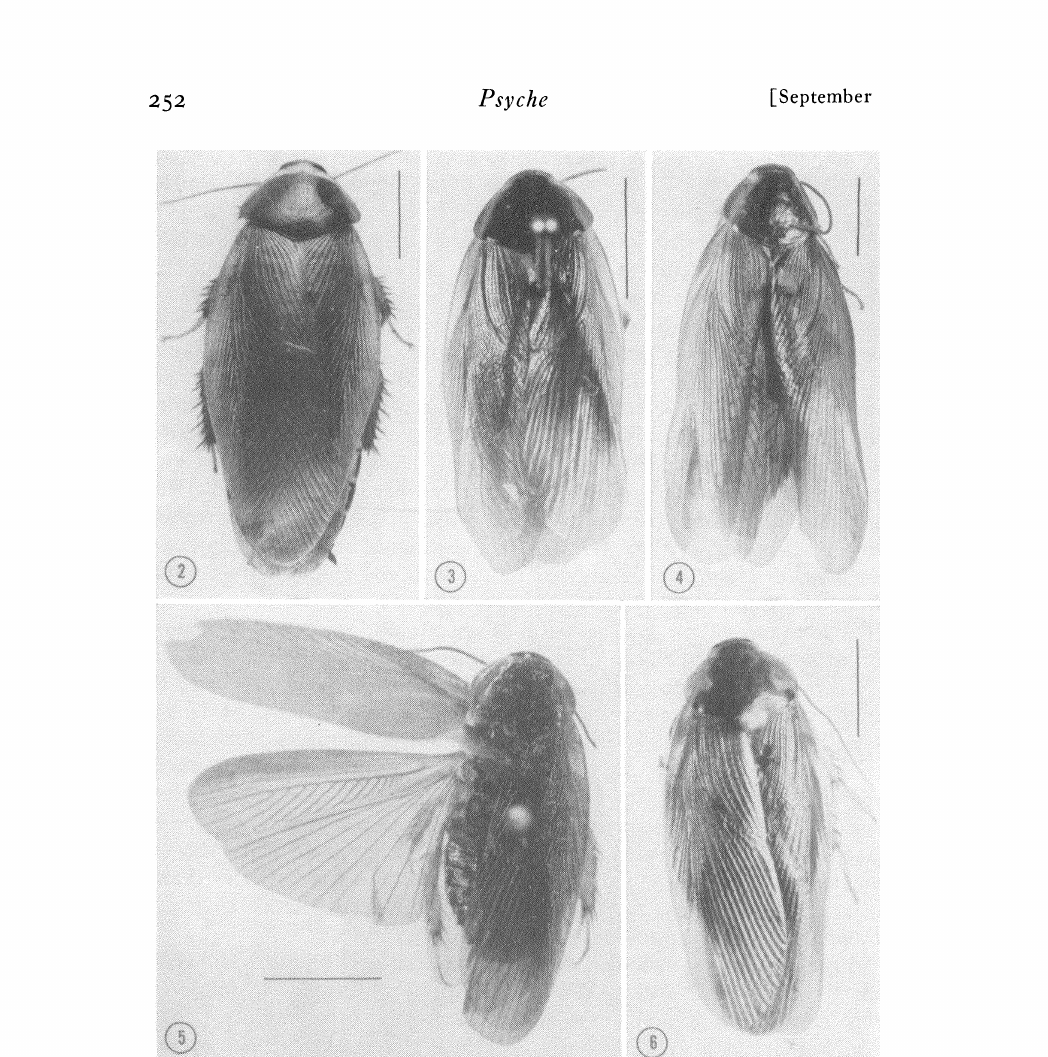
Figs. 2-6. Males of Pyenoseelinae. 2. Pycnoscelus indicus. Sakaerat District, Thailand. From a laboratory colony. 3. (100 MCZ). Pycnoscelus semiitreus. Manila, Philippine. Islands. (det. Prineis). This species was described (Prineis, 1967, p. 148) from 2 8 8 rom Java, Depok. 4. (25 BMNH). Pycnoscelus nigra. Southwest China, Yunnan, Ho-an (leg. J. W. Gregory, 26.V.1922). 5. (1447 L). Pyc’noscelus striata. Kariorang, Borneo, (det. Prineis). 6. (144 ANSP). Stilpnoblatta opaca. Butawa, Modera, S. P. Ceylon (det. by Hebard as S. benyalensis (Sauss)). (scale--5